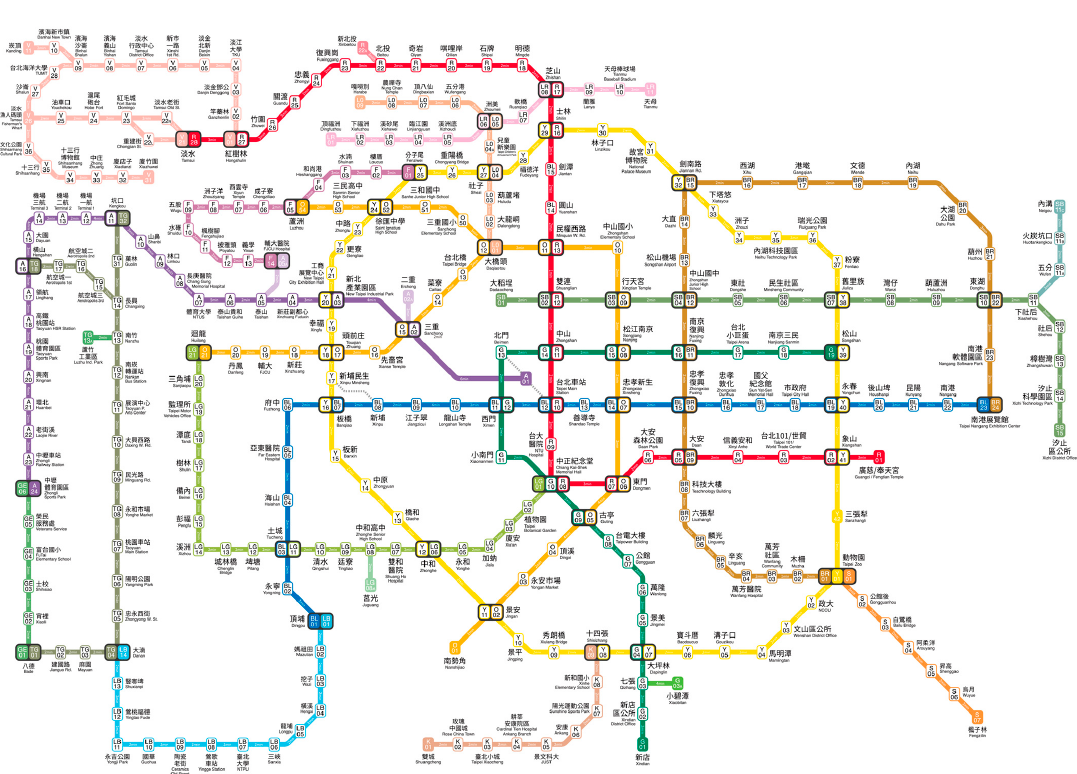
Figure 8. Route map A.